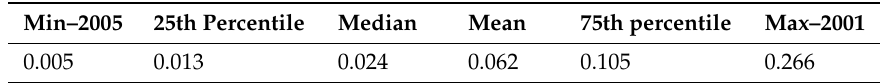
Figure 3. Map depicting the Upper Babocomari Watershed, hydrology, dams, rain gages, and gaging station mapped for this study. Table 1. Daily discharge, cubic meters per second—statistics based on 16 years of record at Upper Babocomari River (near Huachuca City, AZ) discharge gaging station (#09471380;